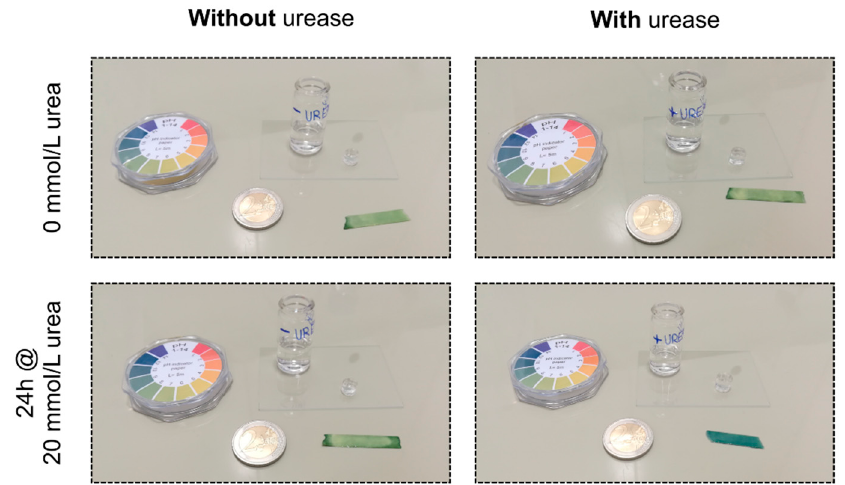
Figure 2. Enzymatic reaction after physical entrapment of the enzyme into the gel via paper-based pH indicators. Due to the enzymatic reactions, the neutral solution (green pH indicator) turns to a measurable alkaline pH change (blue pH indicator).